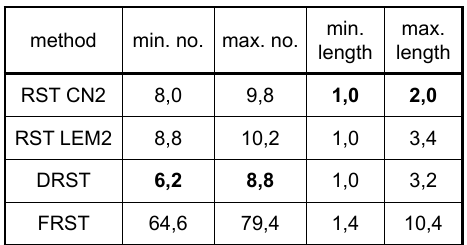
Table 1. Averages of minimum and maximum numbers most favour and rule lengths for all model data (the smallest, able values are in bold) (source: A. Fiedukowicz